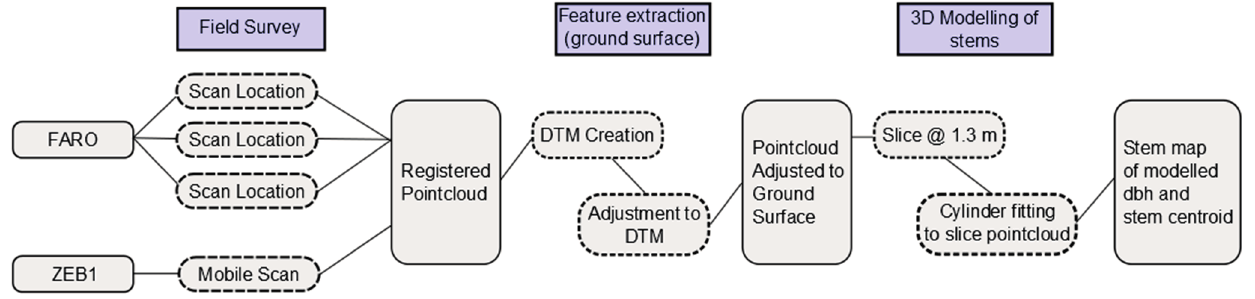
Figure 4. Workflow for data collection and